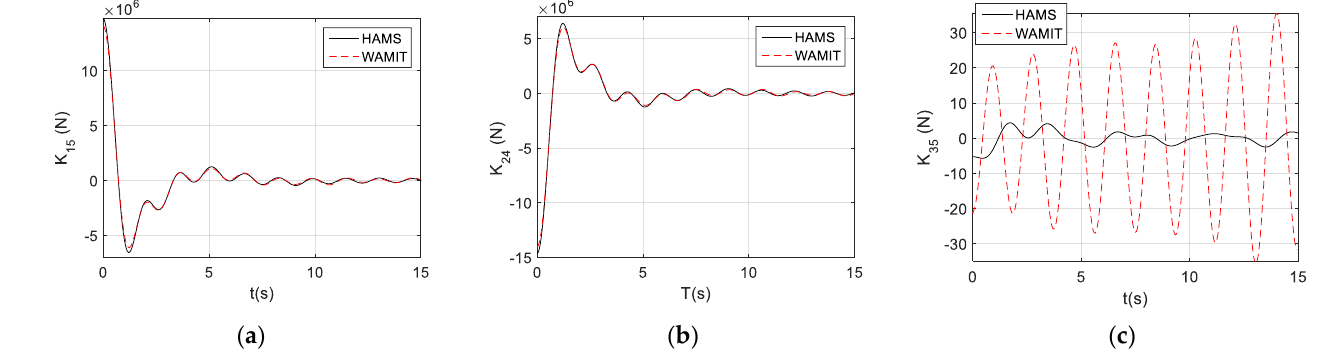
Figure 9. The coupled impulse functions. ( a ) 𝐾 15 ; ( b ) 𝐾 24 ; ( c ) 𝐾 35 .